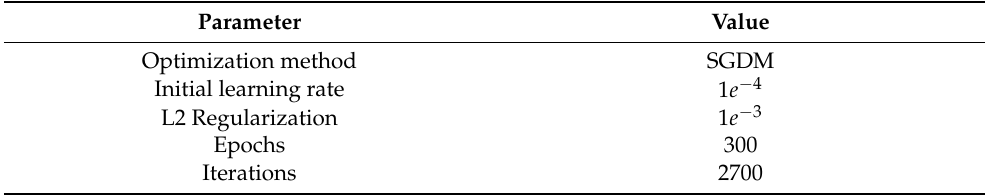
Table 2. Hyper-parameters of